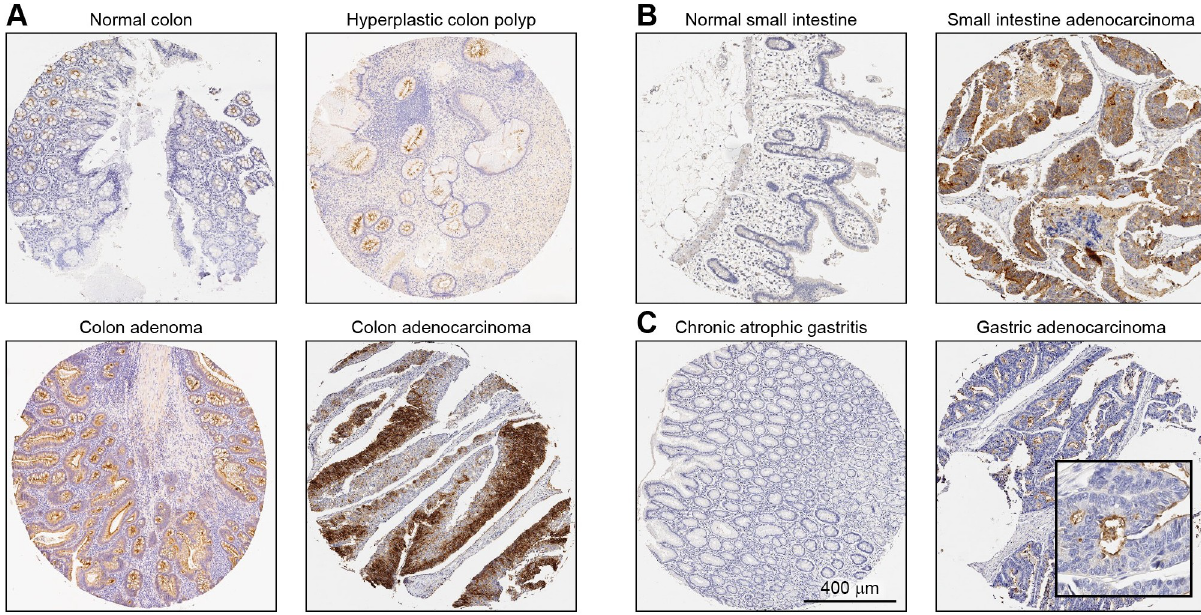
Fig 5. Immunohistochemical detection of NOX1 protein in tumors and corresponding non-neoplastic tissue of the same origin. Representative tumors/lesions and normal/non-neoplastic tissue pairs from a tissue microarray are shown. (A) Normal and abnormal colon, (B) normal and malignant small intestine, and (C) chronic atrophic gastritis and malignant gastric tissue. All images were taken at 10X digital magnification. The scale bar represents 400 μ